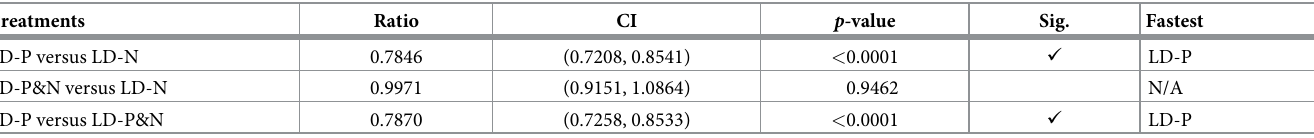
Table 12. LD : Set cardinality time analysis.